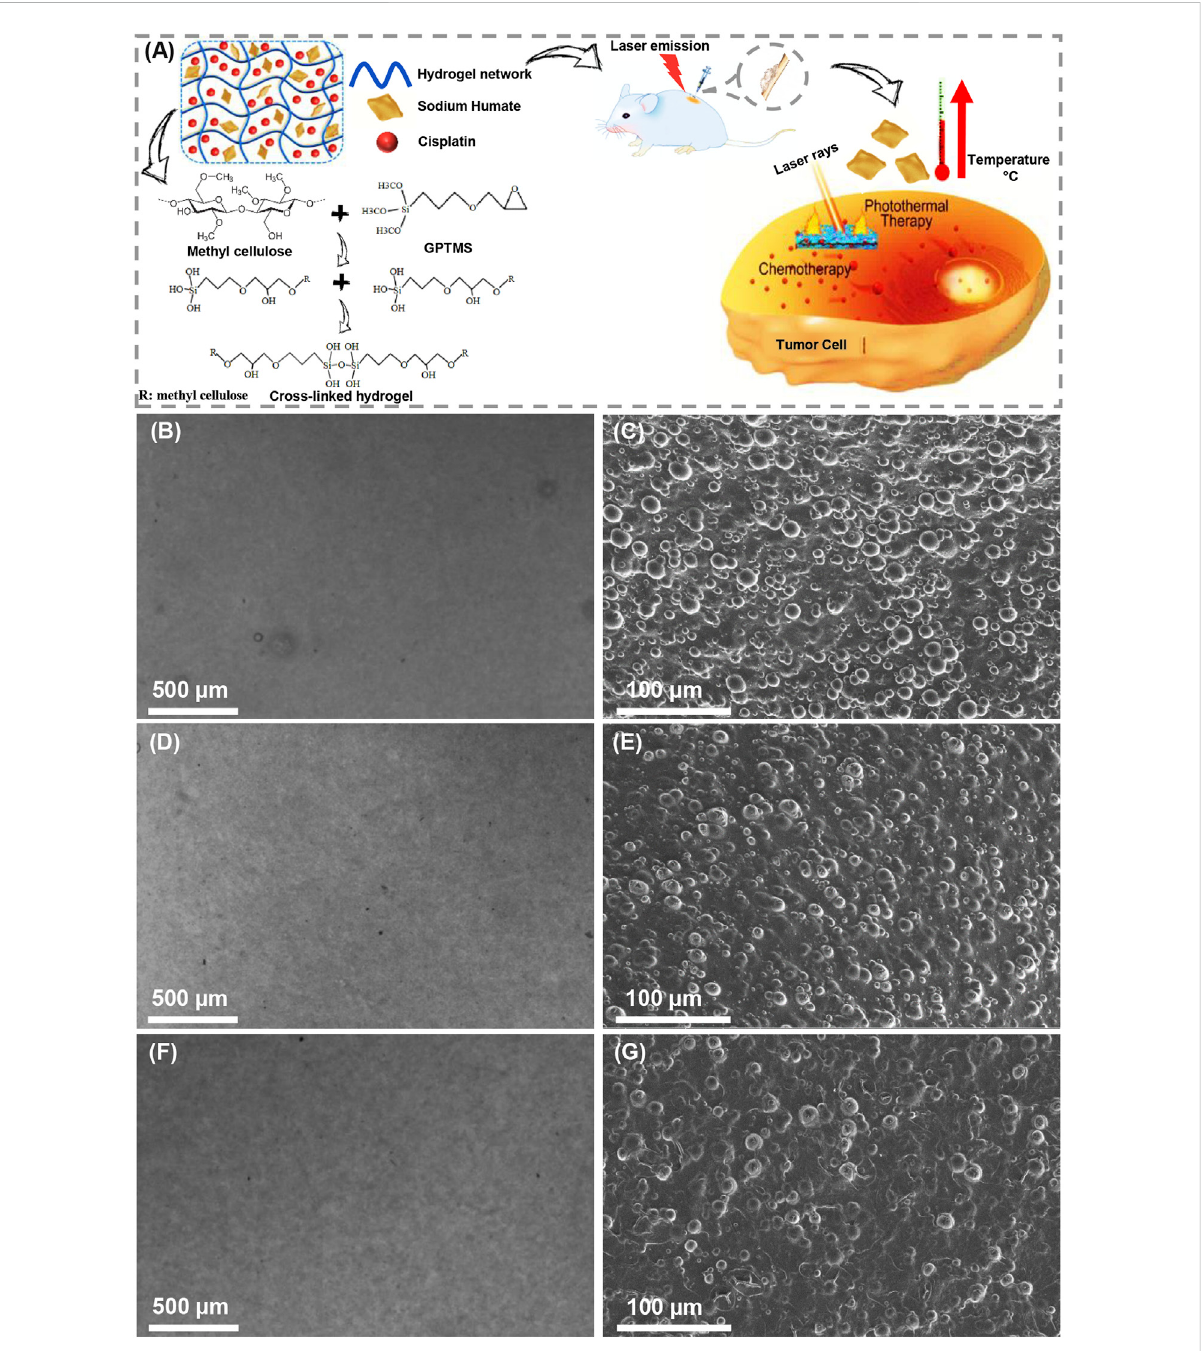
FIGURE 1 Preparation of light-assisted thermo-responsive methylcellulose-sodium humate hydrogels. (A) Schematic of gel formation, cross-linking reaction, and effectiveness of photothermal ablation of tumor cells. (B,D) and (F) Light microscopy images, (C,E) and (G) FE-SEM micrographs of (B,C) MS1, (D,E) MS2, and (F,G) MS3